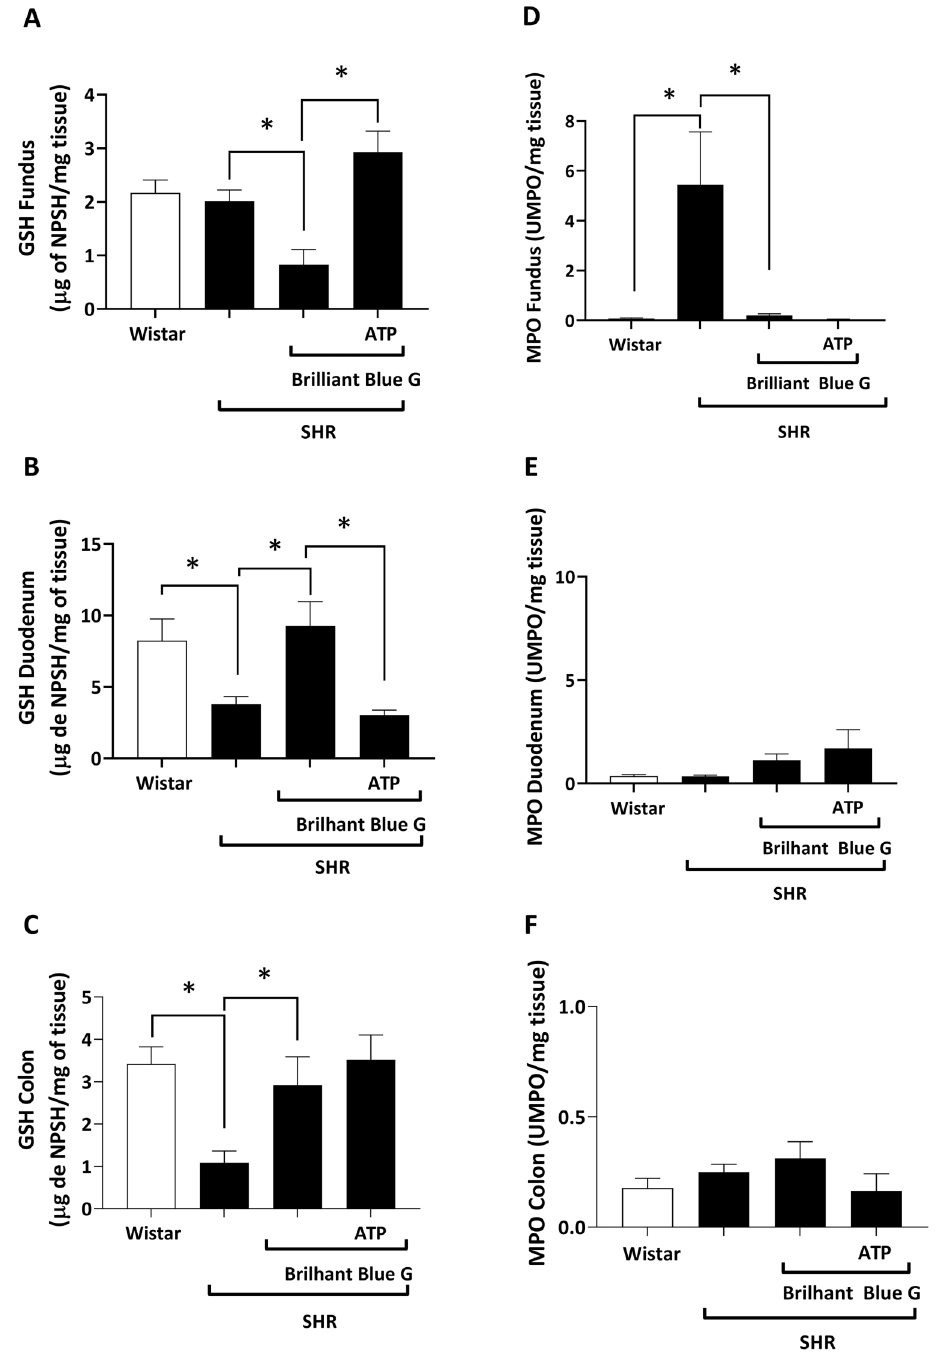
Figure 3. Glutathione (GSH) concentrations in the gastric fundus ( A ), duodenum ( B ), and colon ( C ) of Wistar rats vs spontaneously hypertensive rats (SHR), SHR treated with BBG, and SHR treated with BBG plus ATP. Myeloperoxidase (MPO) activity in the gastric fundus ( D ), duodenum ( E ), and colon ( F ) of Wistar rats vs SHR, SHR treated with BBG, and SHR treated with BBG plus ATP. Data are reported as means ± SE. *P o 0.05 (one-way ANOVA, followed by the Tukey test). BBG: Brilliant Blue G; ATP: adenosine triphosphate; NPSH: non-protein sulfhydryl; UMPO: units of